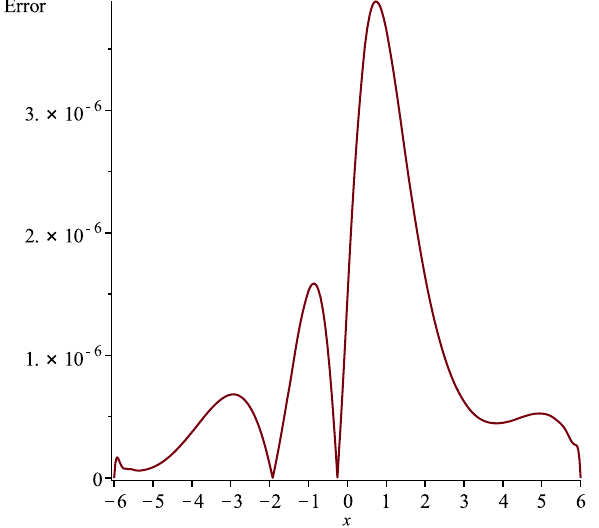
Fig. 2 Plot of the absolute error function for α = 0 . 25, τ = 0 . 02 and t = 1 resulted by GS-RBFs for Example